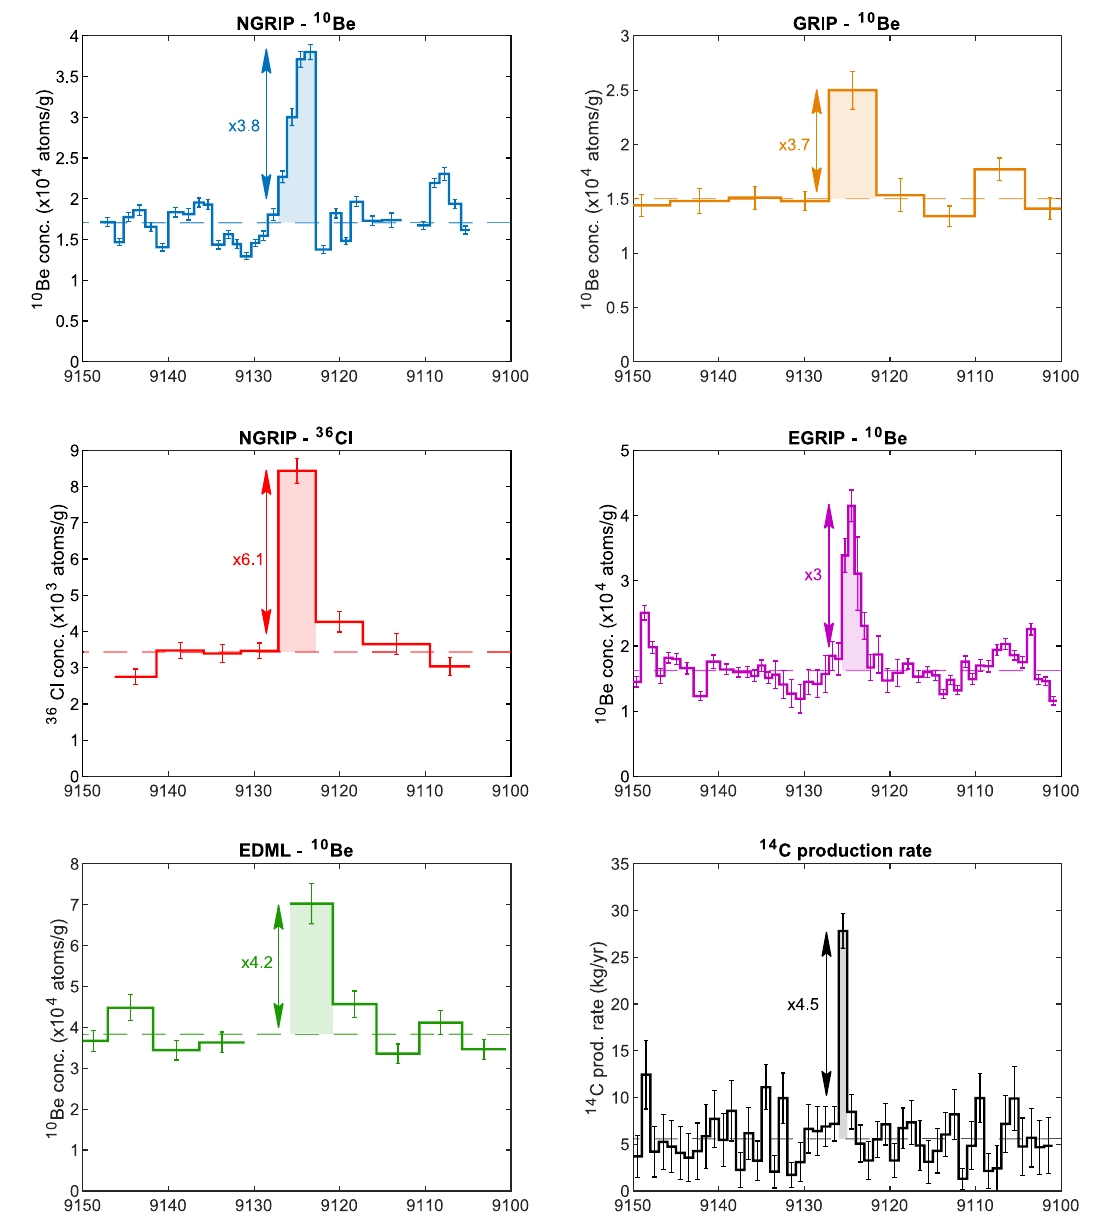
Fig. 1 Cosmogenic radionuclide records for the 9125 years BP event. NGRIP and EDML data are shown on the left, GRIP and EGRIP 10 Be data and 14 C production rate 24 are shown on the right. The baseline (average radionuclide concentration excluding the peak values) is shown as a dashed line. The error bar of each data point includes the measurement uncertainty. The enhancement factors (ratio between integrated enhancements in the radionuclide production and the baseline value) are noted next to the peak for each record. Table 1 Baseline value, integrated enhancement, and enhancement factor of each radionuclide record